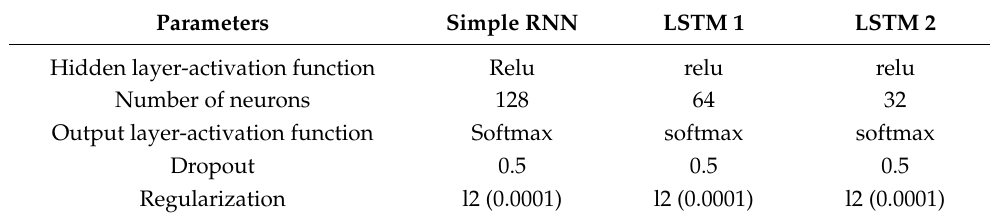
Table 10. Hyper-parameter used to evaluate the proposed hybrid deep learning model.